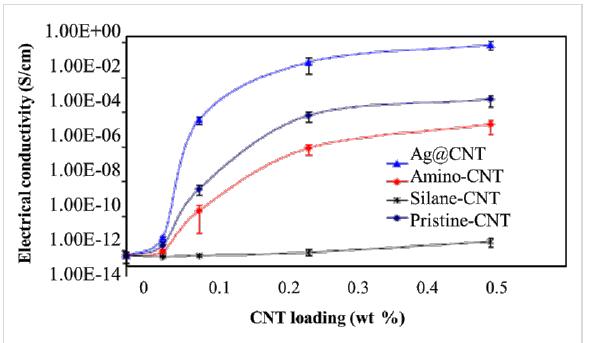
Figure 17: Effect of CNT functionalization on the electrical conduc- tivity of CNT–epoxy nanocomposites [40], copyright 2010 Elsevier.